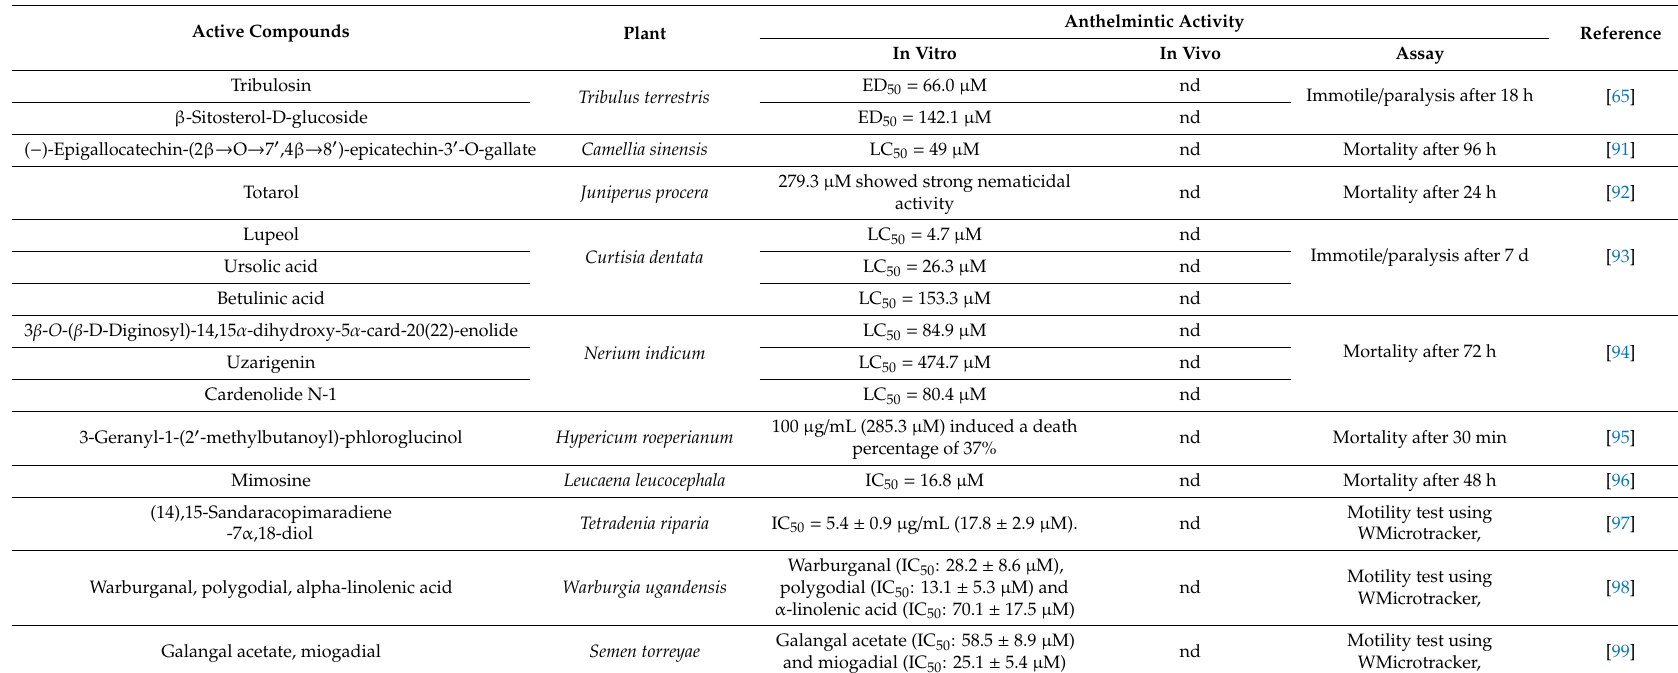
Table 3. List of natural products derived from medicinal plants active against C. elegans